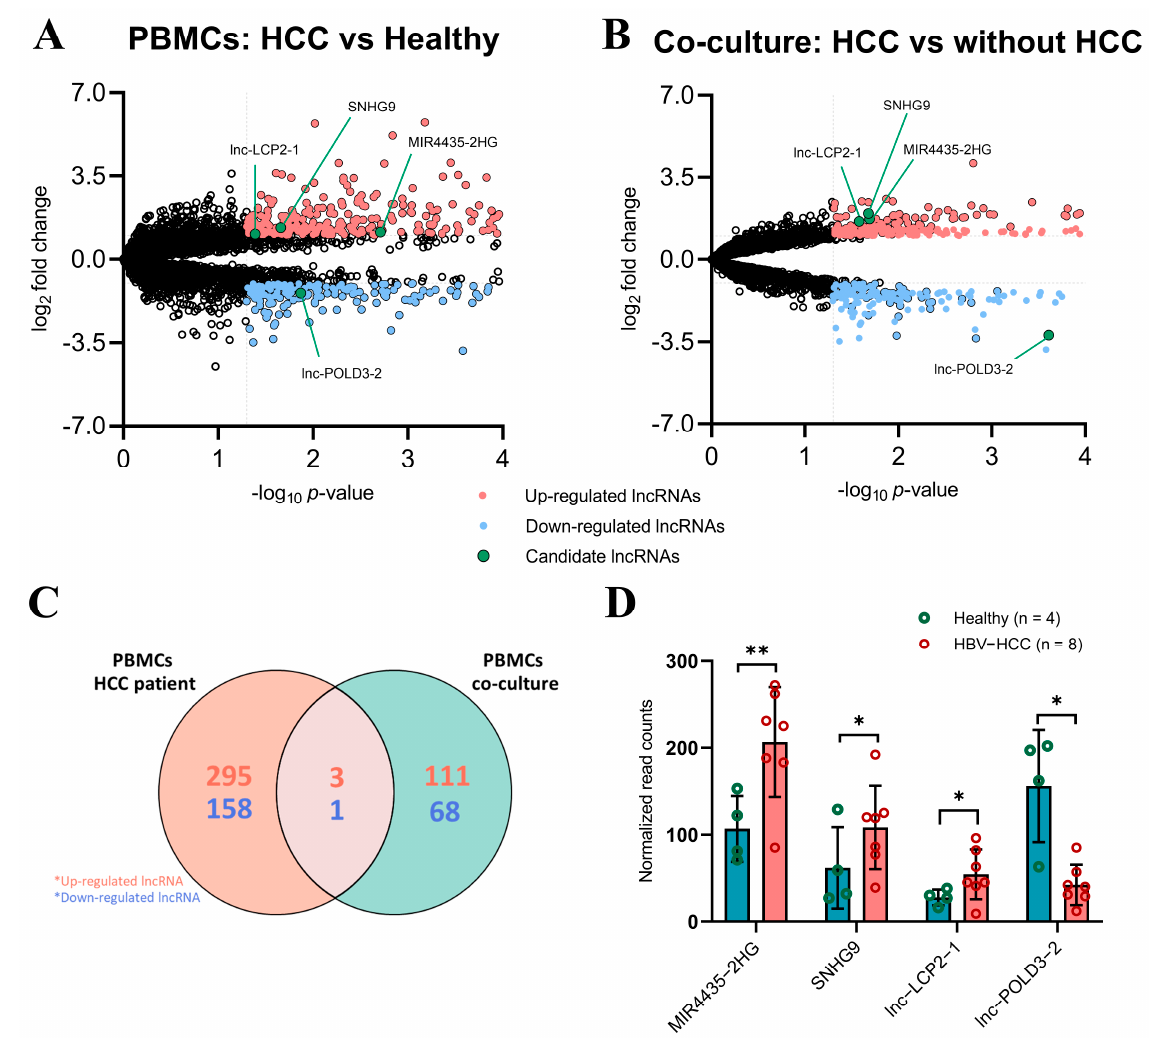
Figure 1. Transcriptomic profile of cancer-induced lncRNAs and integration transcription profiles of PBMCs. ( A ) Volcano plot based on differentially expressed lncRNAs in PBMCs compared with healthy controls. ( B ) Volcano plot based on differentially expressed lncRNAs in PBMCs of co-culture compared with control. Volcano plot shows − log 10 p -values on the y -axis and fold change expressed as log 2 on the x -axis. Red scatter dots represent up-regulated lncRNAs with p ≤ 0.05 and log 2 fold change ≥ 1. Blue scatter dots represent down-regulated lncRNAs with p ≤ 0.05 and log 2 fold change ≤ − 1. Green scatter dots represent a candidate of cancer-induced lncRNAs for validation in PBMCs. ( C ) The Venn diagram represents intersect genes between two transcription profiles of PBMCs including PBMCs from patients with HCC and PBMCs from a co-culture model. ( D ) Comparison of cancer-induced lncRNAs expression in PBMCs of patients with HCC and healthy controls. * p < 0.05, ** p < 0.01.